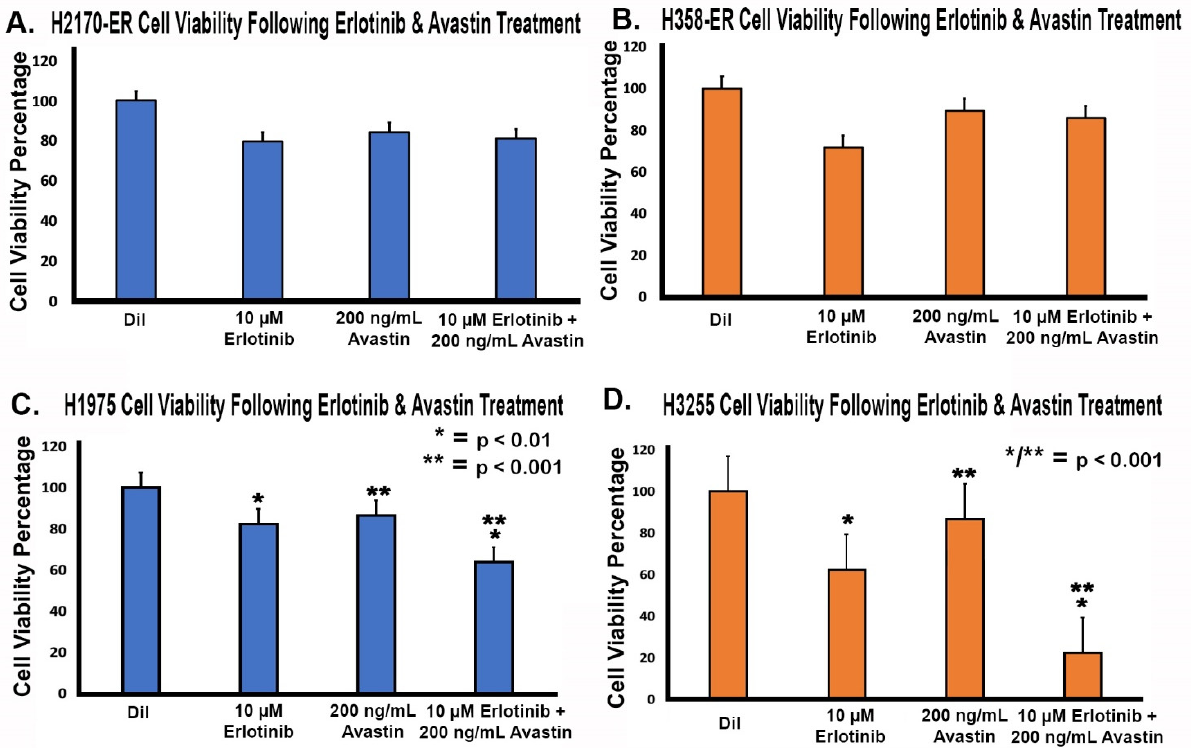
Figure 6. Effect of anti-VEGF treatment in NSCLC cell lines. A total of 8,000 H2170-ER, H358-ER, H1975, and H3255 NSCLC cells were treated with diluent (control), 10 µ M Erlotinib